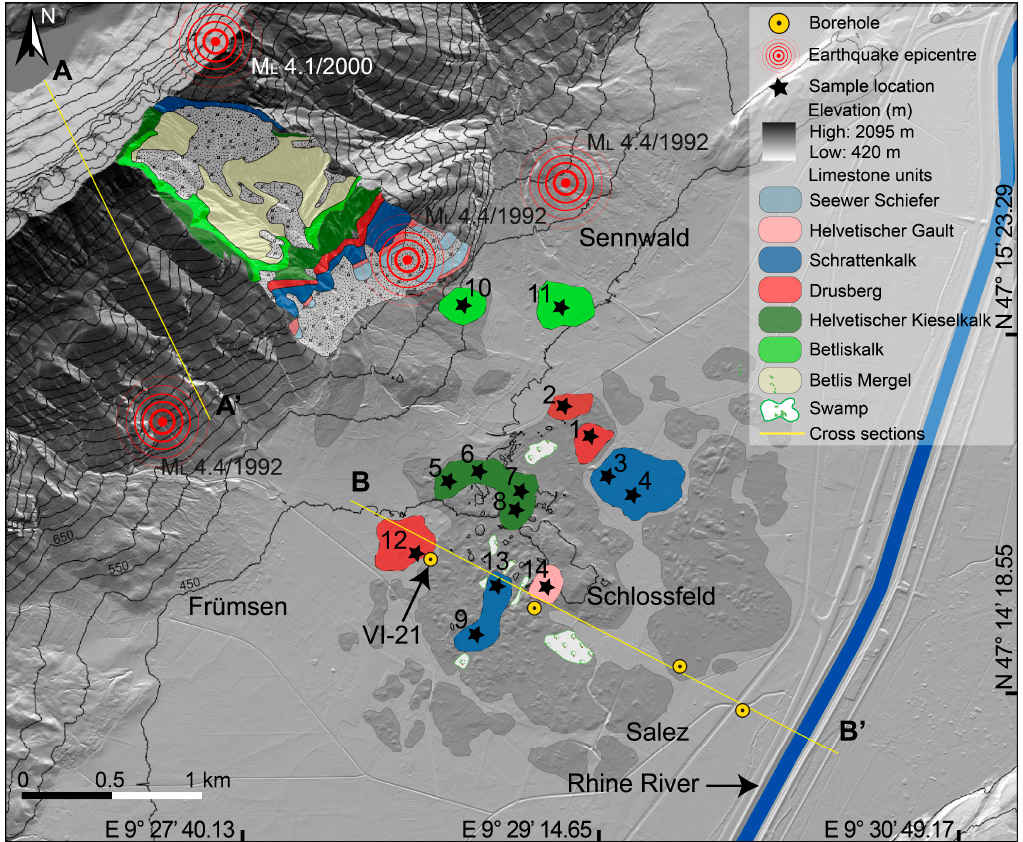
Figure 5. Surface map showing landslide deposits (grey), the dominant boulder lithologies in each sector (blue, yellow, red, green and pink) in the deposition area and the sampling locations (black asterisks indicated with sample numbers). Moderate earthquake epicentres (red asterisks) are also indicated. Altitude is given by colour code. Shaded relief image of the Sennwald region superimposed by a color-coded DEM (swissALTI3D) reproduced by the permission of Swisstopo.